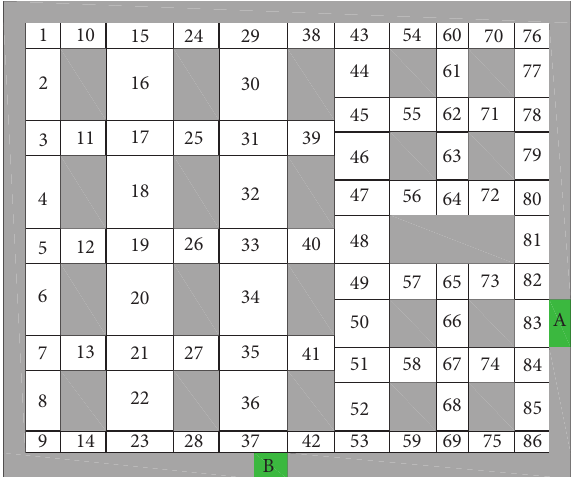
inSSG − correspondingindexin DSG ) × 100%/the statistical indexin SSG.